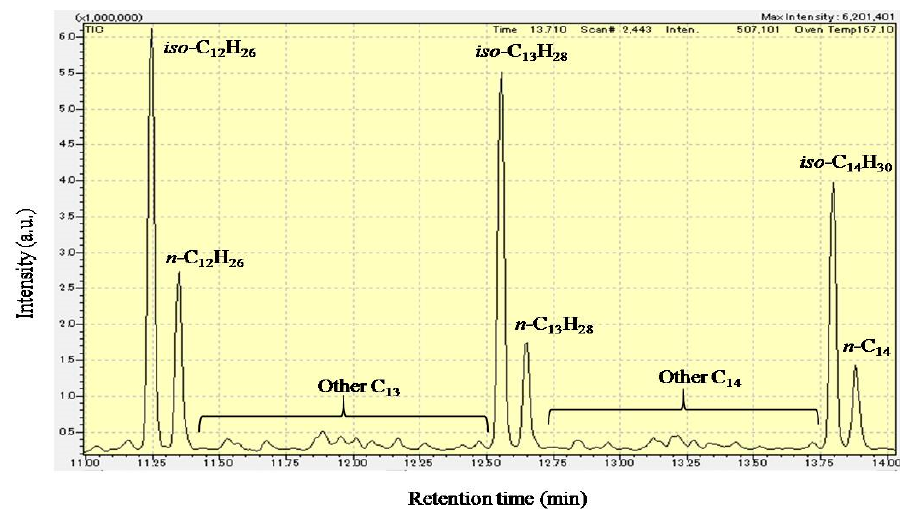
Figure 5. GC-MS chromatogram (retention time: 11–14 min) of liquid products from the hydrocracking of hydrocracking over Pt / Al / MCM-48 at 573 K for 4 h.